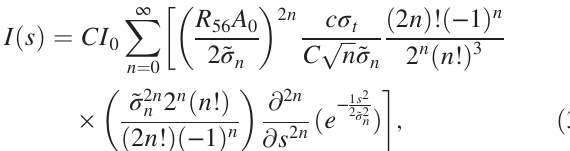
FIG. 2. Comparison of analytical model with ELEGANT simu- lation of a laser heater plus bunch compressor. (a) Current profiles for small and large laser power. At large power, multiple terms are required for the series solution to converge. (b) Peak to peak current modulation as a function of laser intensity, with callouts for the points shown to the left.